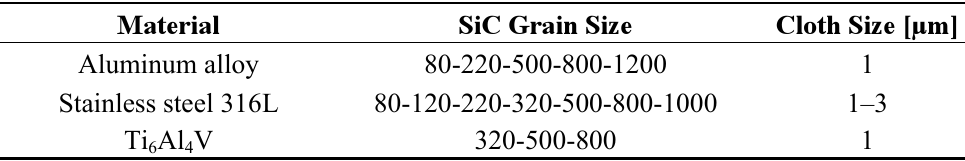
Table 4. Metallographic specifications.